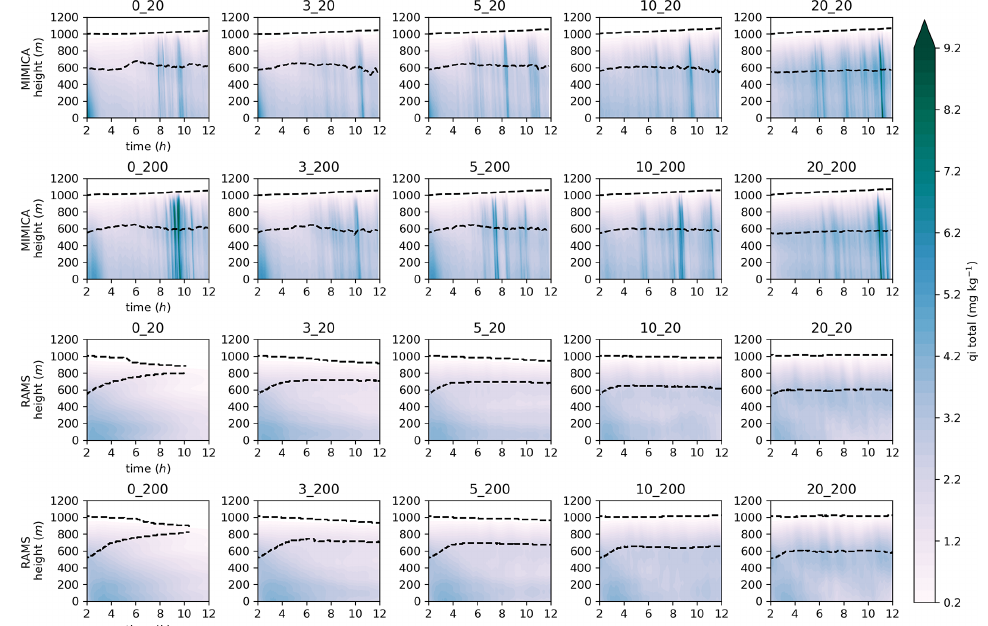
Figure A5. Total ice mixing ratio (qi total) for the MIMICA and RAMS simulation sets. The first 2h of simulations, considered as the spin-up period, are excluded. For figure clarity, the plot titles have been abbreviated; the first number refers to the accumulation mode and the second to the Aitken mode concentration in cubic centimetres, i.e. 0_20 refers to AC0_AK20. Black dashed lines represent the cloud top and cloud base